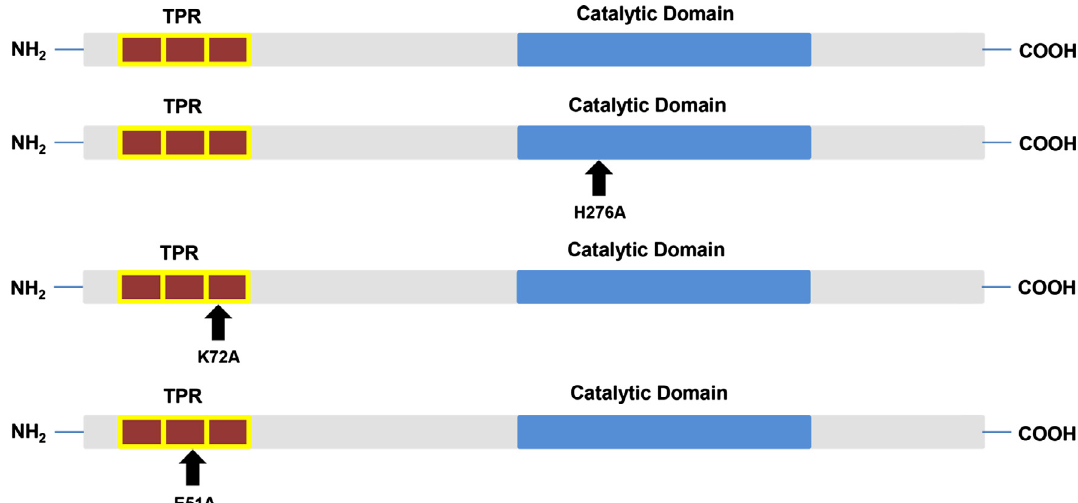
Figure 5. PP5 structure. Leishmania PP5 contains a TPR domain made of three TPRs (red) and one phosphatase catalytic domain (blue). Site- directed mutagenesis was performed to change Histidine to Alanine at position 276 [H276A], Lysine to Alanine at position 72 [K72A], and Glutamic Acid to Alanine at position 51 [E51A].